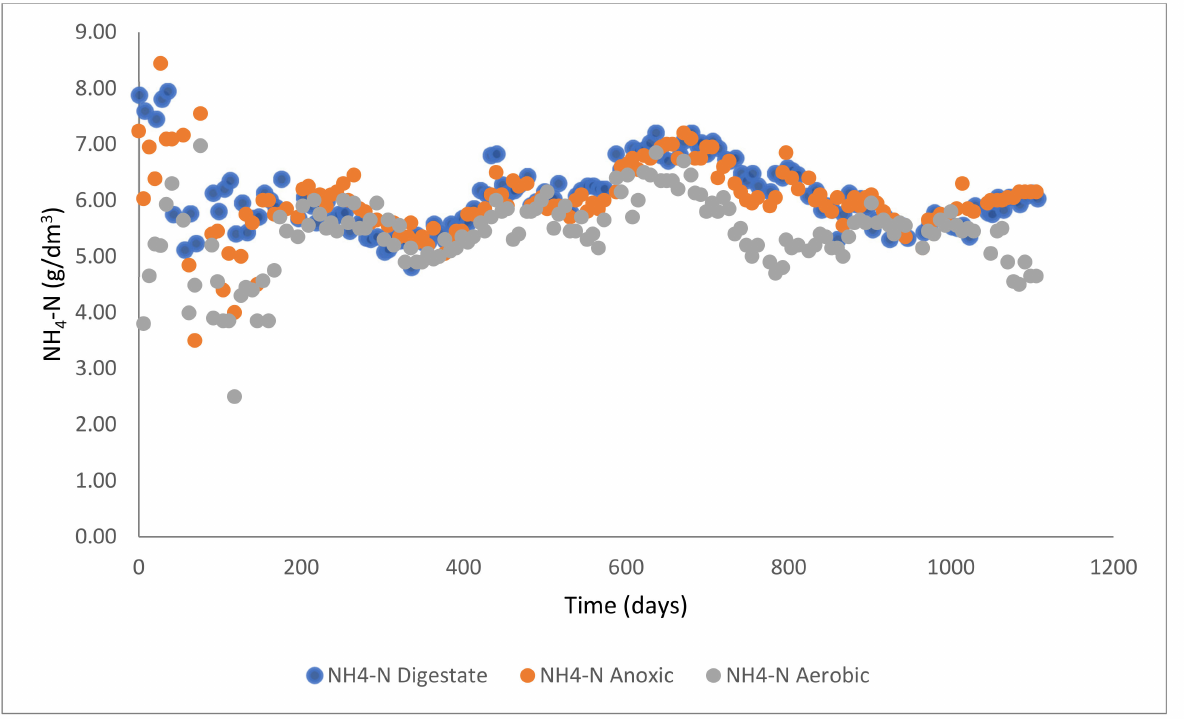
Figure 6. NH 4 -N concentration at each